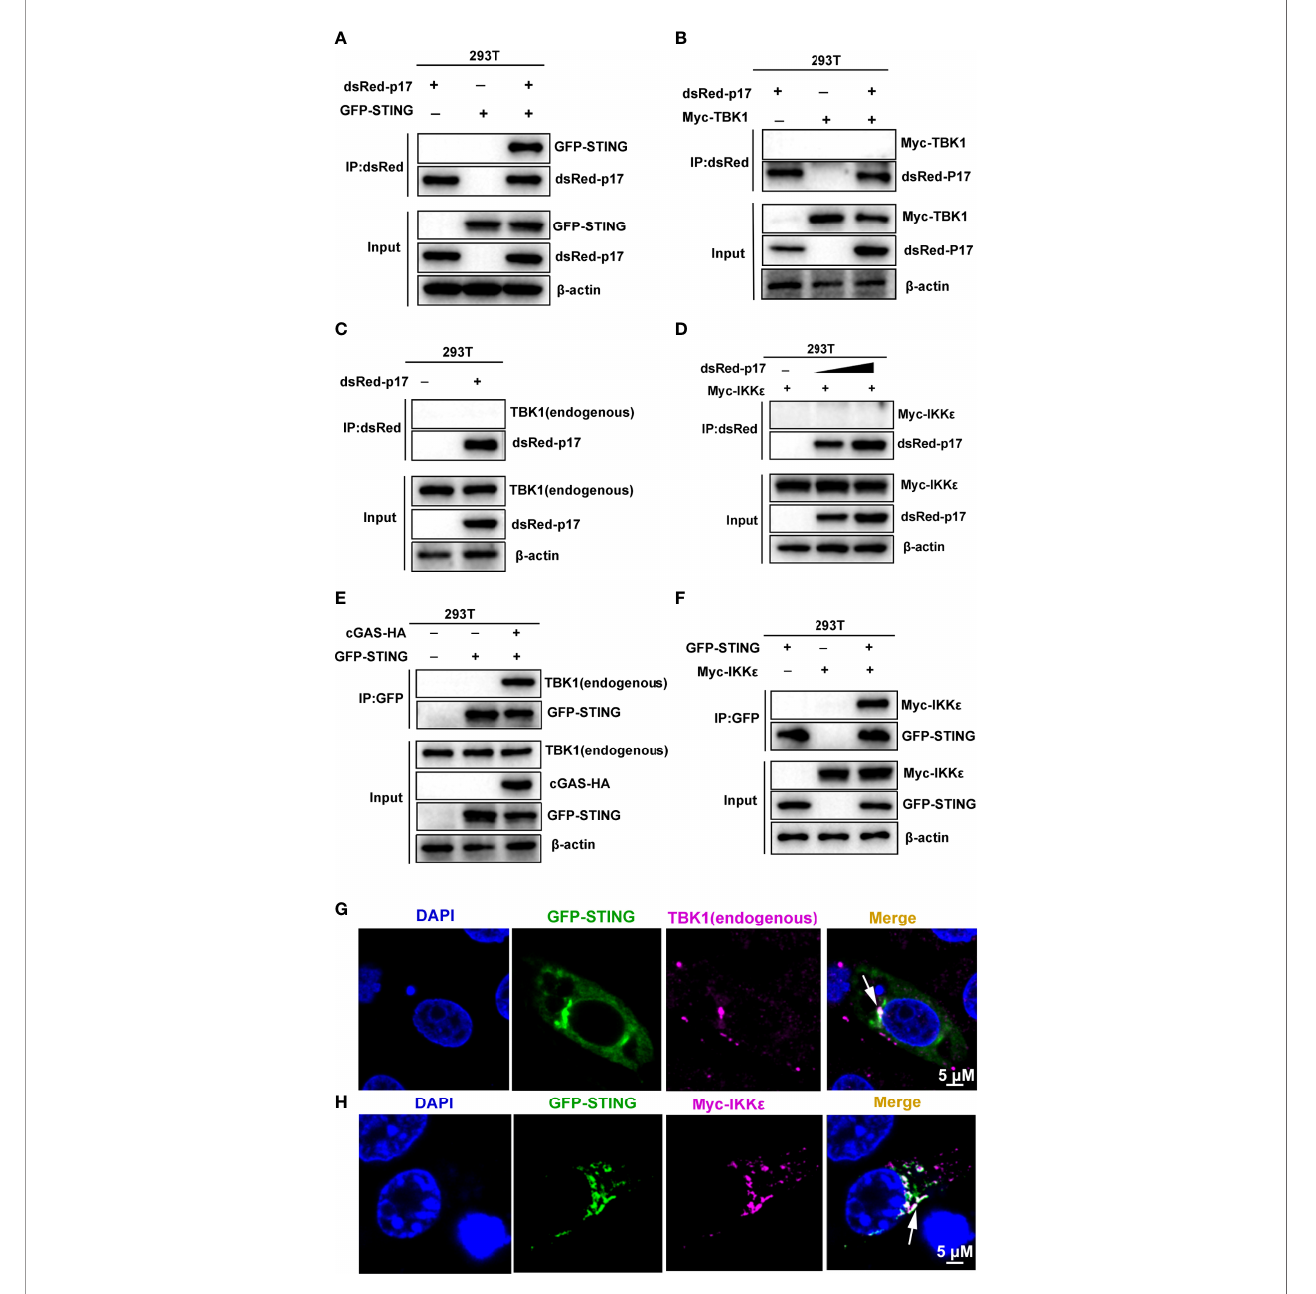
FIGURE 5 | (A – F) Co-immunoprecipitation assays for analyzing the interactions between p17, STING, TBK1 and IKK ϵ . (A) pDsRed-p17 (0.5 m g) and pGFP-STING (0.5 m g) were co-transfected into 293T cells in 6-well plate for 24 h (B) pDsRed-p17 (0.5 m g) and pMyc-TBK1 (0.5 m g) were co-transfected into 293T cells for 24 h. (C) pDsRed-p17 (1 m g) was transfected into 293T cells for 24 h (D) pDsRed-p17 (0.5 m g and 1 m g) and pMyc-IKK ϵ (0.5 m g) were co-transfected into 293T cells for 24 h. (E) The pGFP-STING (0.5 m g) and pcGAS-HA (0.5 m g) were transfected into 293T cells for 24 h. (F) The pGFP-STING (0.5 m g) and pMyc-IKK ϵ (0.5 m g) were co-transfected into 293T cells for 24 h The cell lysates were subjected for immuno-precipitation and subsequent Western blotting using the indicated tag antibodies. As a control in A, there is no interaction between GFP and dsRed (data not shown). (G, H) The cellular co-localizations between STING and TBK1/IKK ϵ were analyzed by using IFA. (G) The pGFP-STING (1 m g) were transfected into 3D4/21 cells for 12h and then stimulated by transfection of polydA:dT (1 g/mL) for another 12h. The endogenous TBK1 was stained by rabbit anti-TBK1 mAb and Alexa Fluor plus 647 anti-rabbit second antibody, and the stained cells were examined by confocal microscopy. (H) The pGFP-STING (0.5 m g) and pMyc-IKK ϵ (0.5 m g) were co-transfected into 3D4/21 cells for 24 h. The Myc-IKK ϵ was stained with rabbit anti-Myc pAb and Alexa Fluor plus 647 anti-rabbit second antibody, and stained cells were observed by confocal microscopy. The arrows illustrate the co-localized